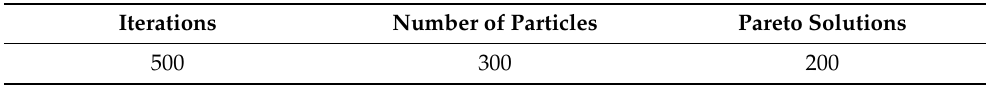
Table 4. The basic parameters of the MOPSO algorithm. Iterations Number of Particles Pareto Solutions 500 300 200